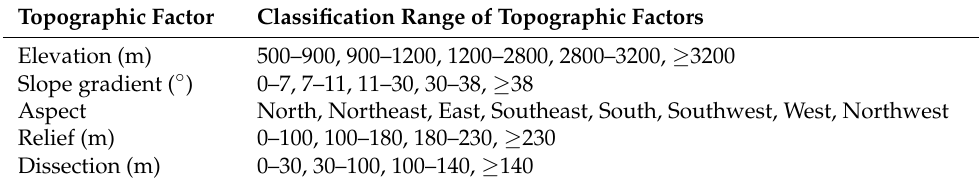
Table 2. Reclassification of topographic factors.